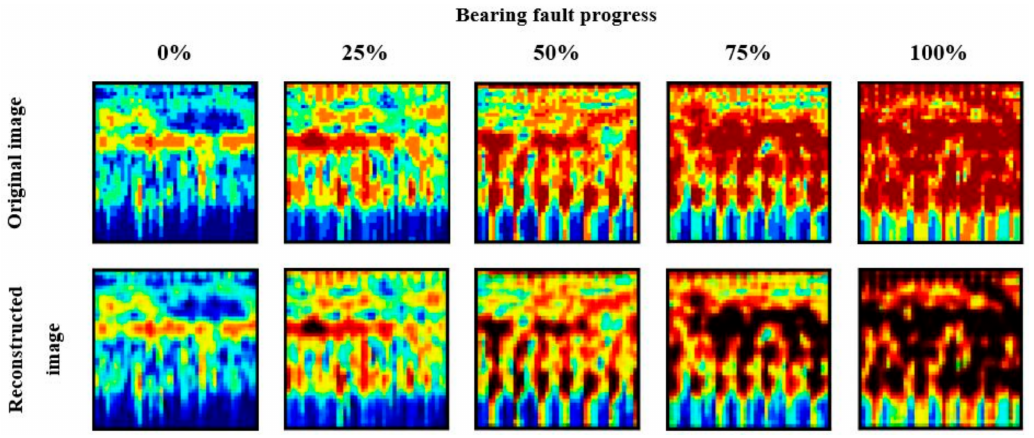
Figure 9. Comparison of the original and reconstructed images of the wavelet power spectrum during the run-to-failure experiment of the subset 2 bearing